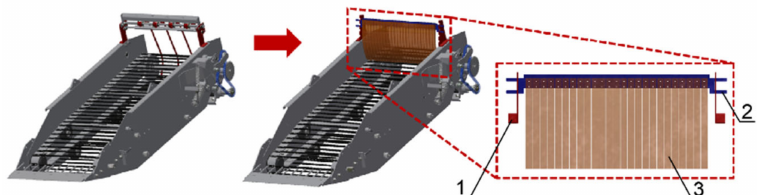
Figure 3. Schematic diagram of the stem transported-posture adjustment mechanism. 1. Multi-stage hook; 2. Curtain hanging plate; 3. Elastic